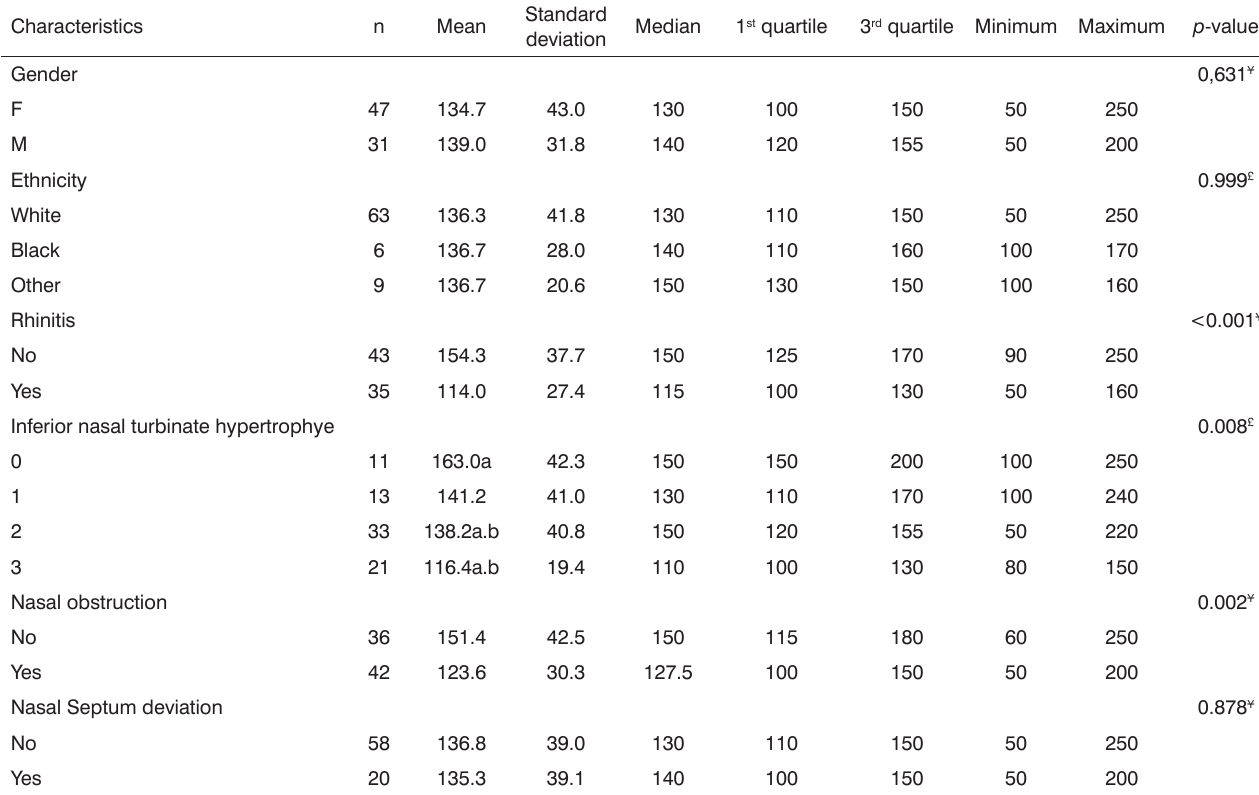
Table 3. NIPF comparison according to sample demographic and clinical characteristics.